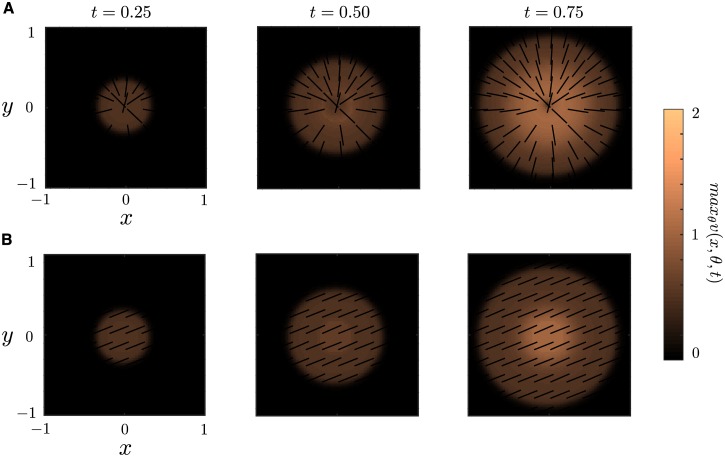
Two-dimensional target patterns.Numerical simulation of Eqs (4a) and (4b) for (A) anisotropic connection A(θ) = 1 + cos(2θ) and (B) isotropic connections A ≡ 1. All parameter values are the same as in Fig 6 and we take r
0 = 0.1. All weight functions are the 2D analogs of the functions used for 1D.